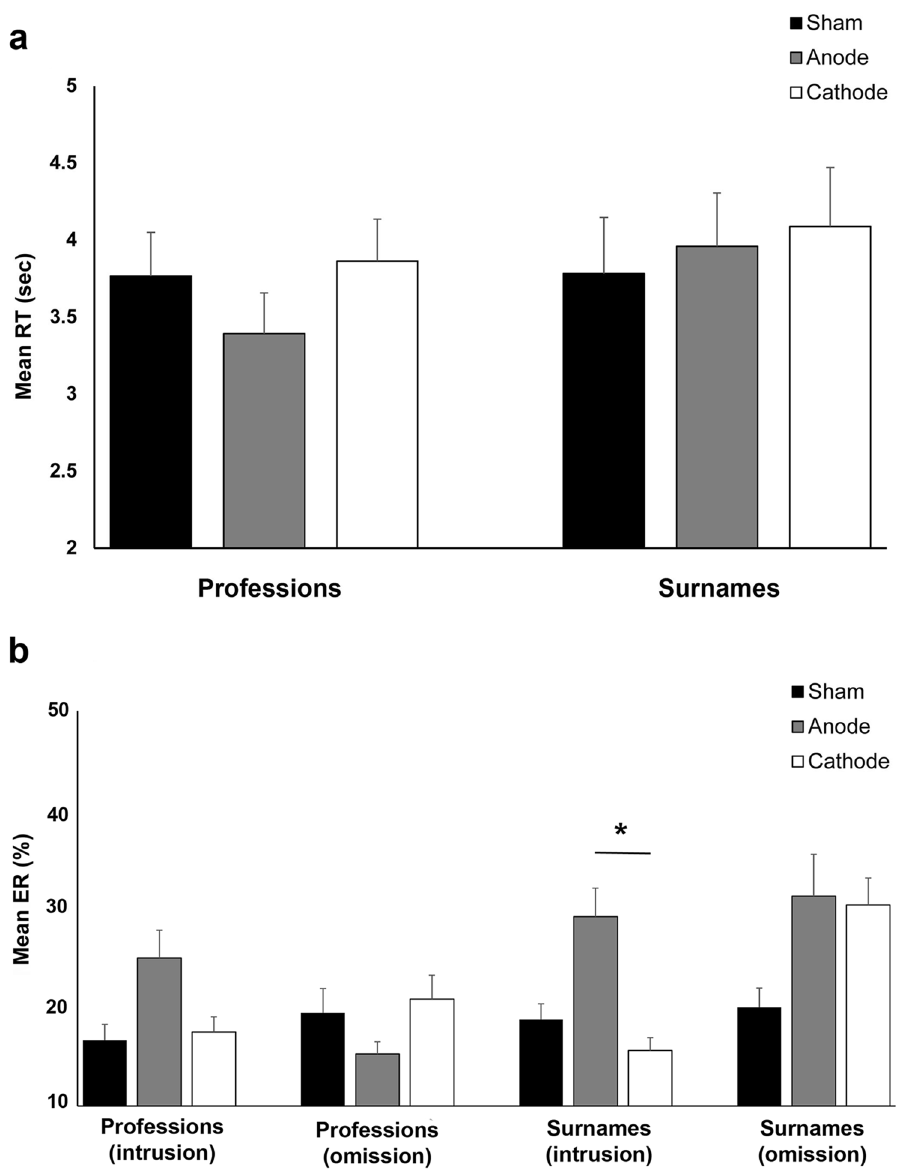
Figure 3. Effects of right ATL tDCS on the recall of person-specific information ( a ) Reaction times (RTs) during early recall. The x-axis displays the person-specific information and stimulation conditions. The y-axis represents the mean RTs (sec) of correct trials. Overall, RTs were significantly shorter in anodal condition compared to cathodal condition. ( b ) Error rates (ERs) during early recall. The x-axis displays the error type, person-specific information and stimulation conditions. The y-axis represents the mean ERs (%). Overall, there were more intrusions in the anodal condition compared to the cathodal condition. * Indicates significant differences in ER between stimulation conditions. Error bars represent the standard error of the mean